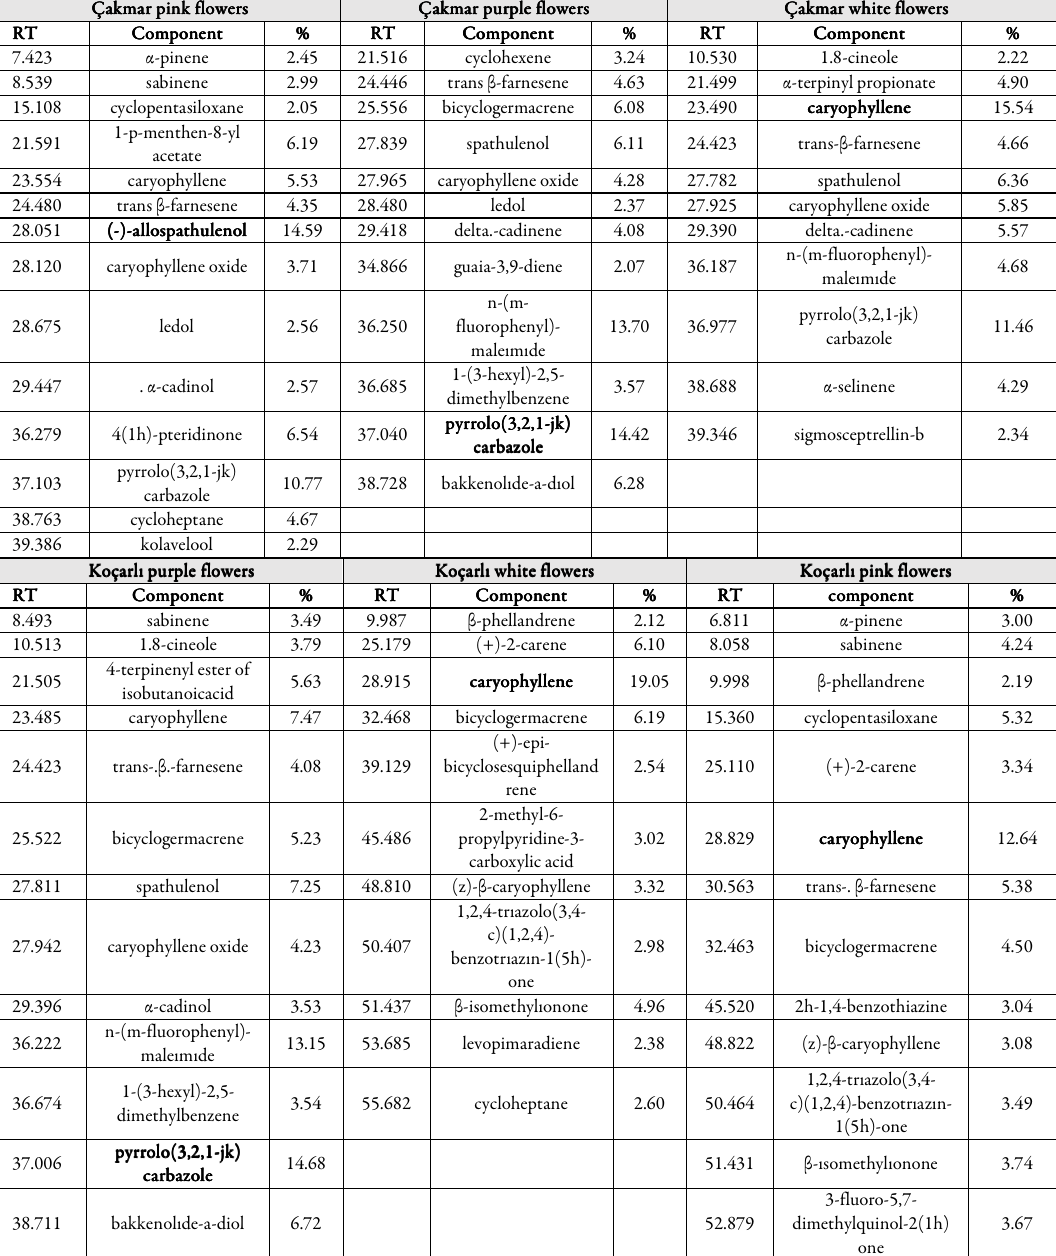
Table 1. Composition of the essential oil from Vitex agnus-castus flowers of different populations Çakmar pink flowers Çakmar purple flowers